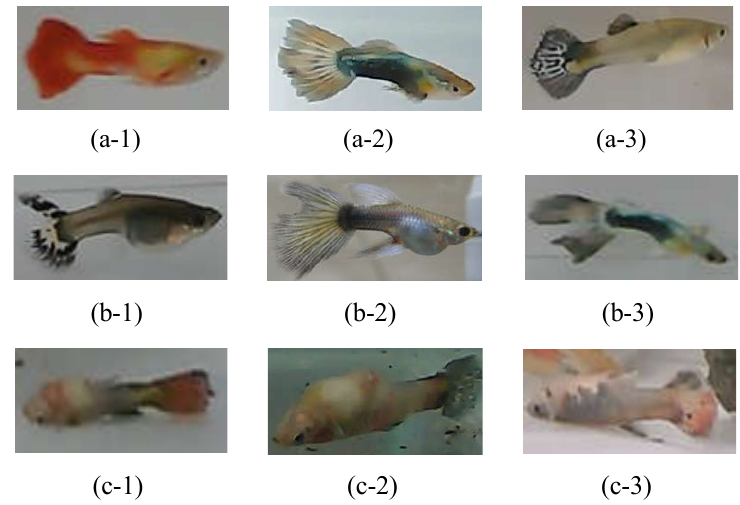
Figure 4. Three physiological states of guppies: ( a ) healthy, ( b ) rotten-tail, and ( c ) dead.